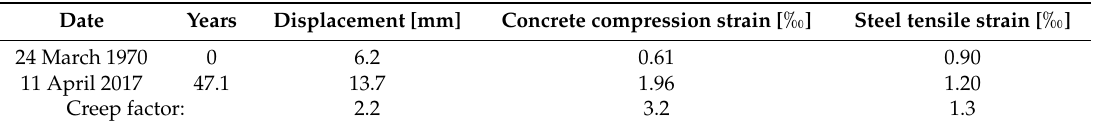
Table 1. Overview of the measured displacements and strains shortly after loading and after 47 years of long-term monitoring. Furthermore, the creep factors are given.